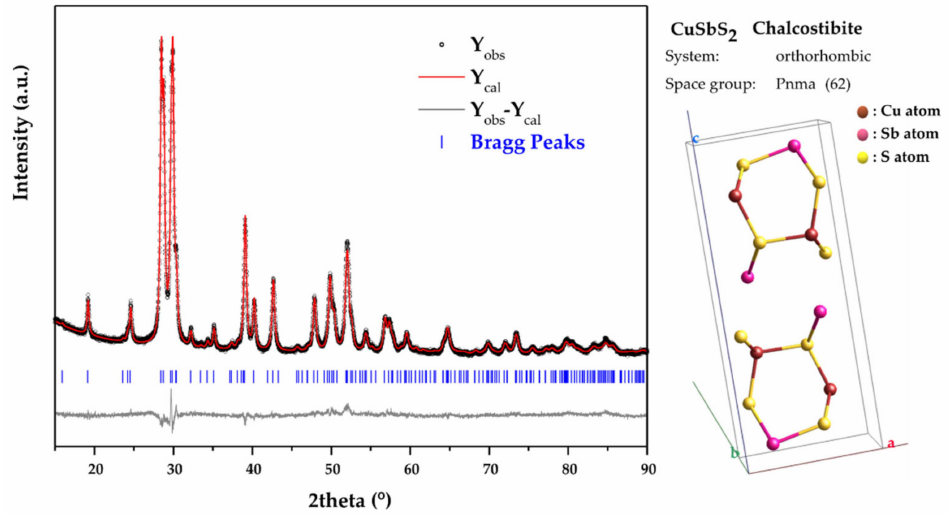
Figure 2. Rietveld refinement of the XRD pattern of CuSbS 2 powders directly produced by mechanochemical